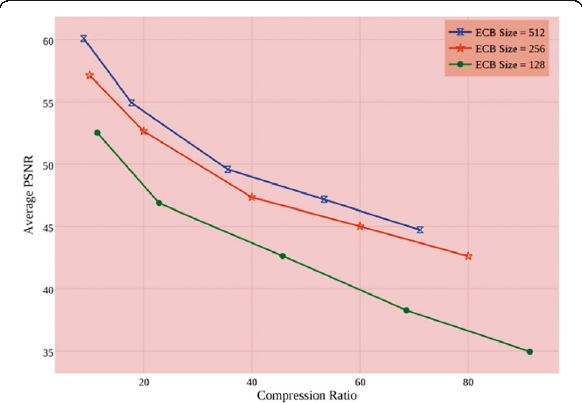
Fig. 11 Average CR Vs Average PSNR graph for ECB size = 512, 256, and 128 for DB1 using PE-VQ